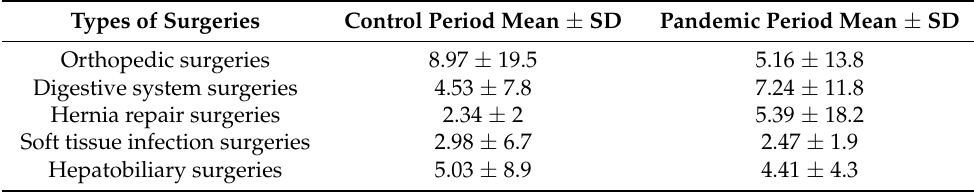
Table 2. Days of